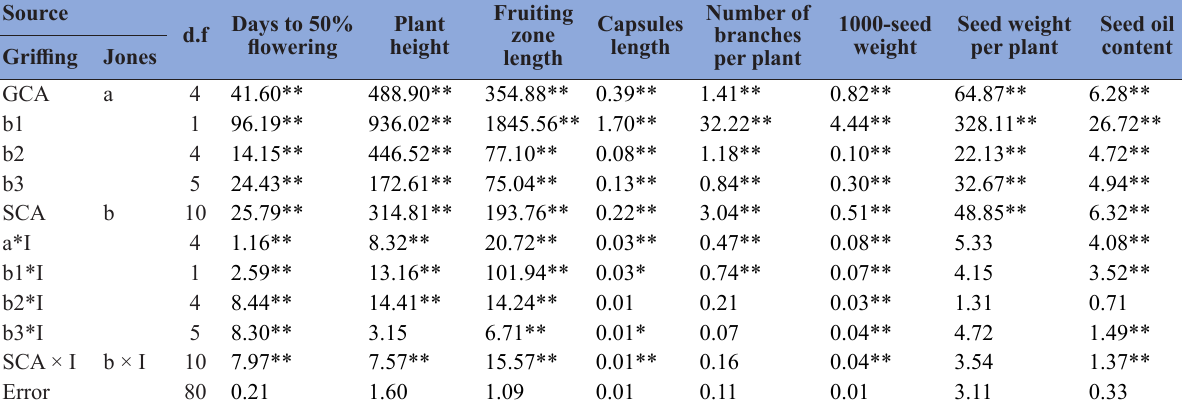
Table 7. Half diallel’s analyses with Griffing method 2 model 1 (1956) and Jones (1965) for all studied traits across irrigation regimes in 2019